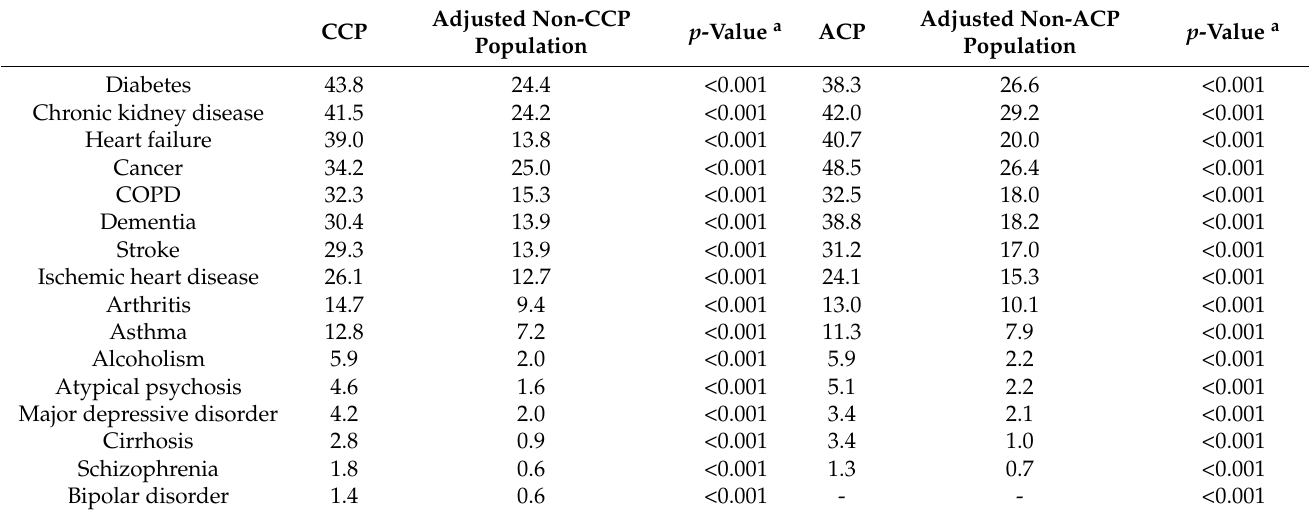
Table 5. Main comorbidities in complex chronic and advanced chronic patients and their corresponding non-CCP and non-ACP populations adjusted by age, sex, and annual income (year 2019),